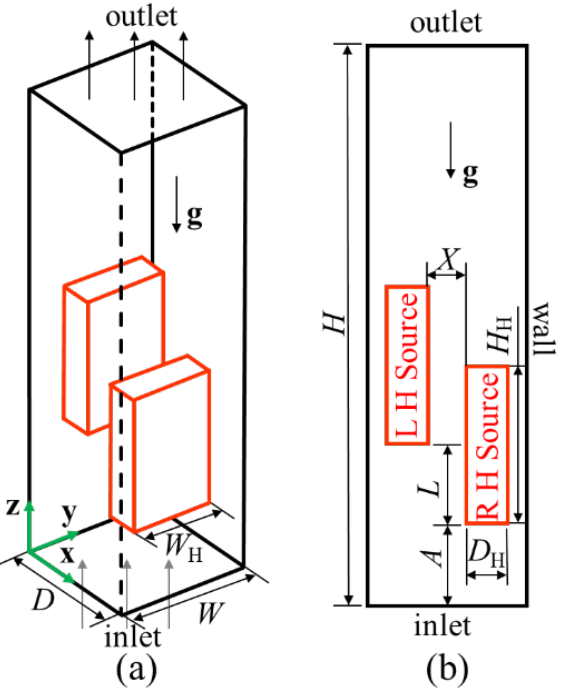
Figure 1. The physical model ( a ) and the x - z plane at y = W /2 of the open-ended square channel ( b ). Table 1. Thermophysical parameters of air and heat sources.